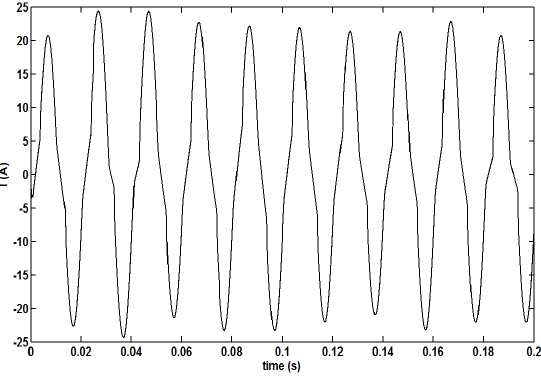
Figure 8. A typical current of HIF with randomness and asymmetry behavior.